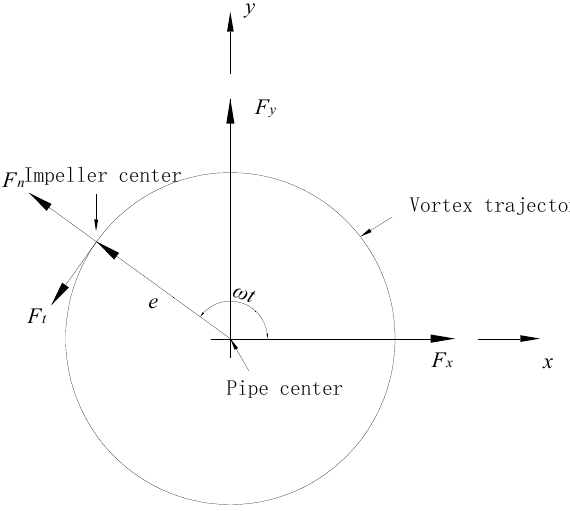
of fluid force inside the impeller on rotor dynamic characteristics [32]. M is the directly damping coefficient; c is the cross-coupling damping coefficient; K is the direct stiffness coefficient; k is the cross-coupling stiffness coefficient. To simplify the research, the vortex frequency ratio of the mixed-flow pump impeller is ( ω /n ) set to 0, 0.2, 0.4, 0.6, 0.8, and 1.0, respectively.